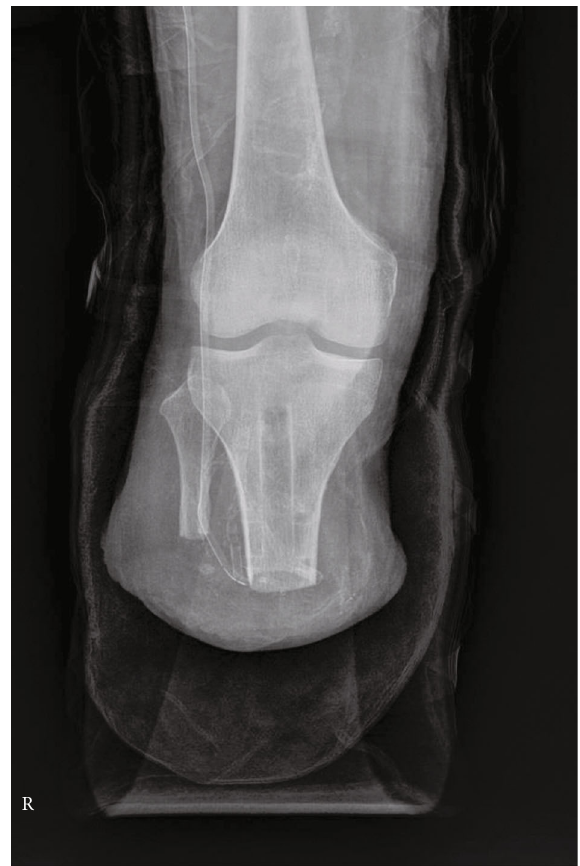
Figure 5: Postoperative plane radiograph. No hardware remained after